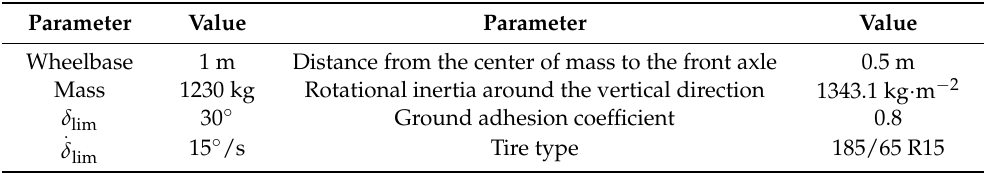
Table 1. Parameters of the car-like robot.